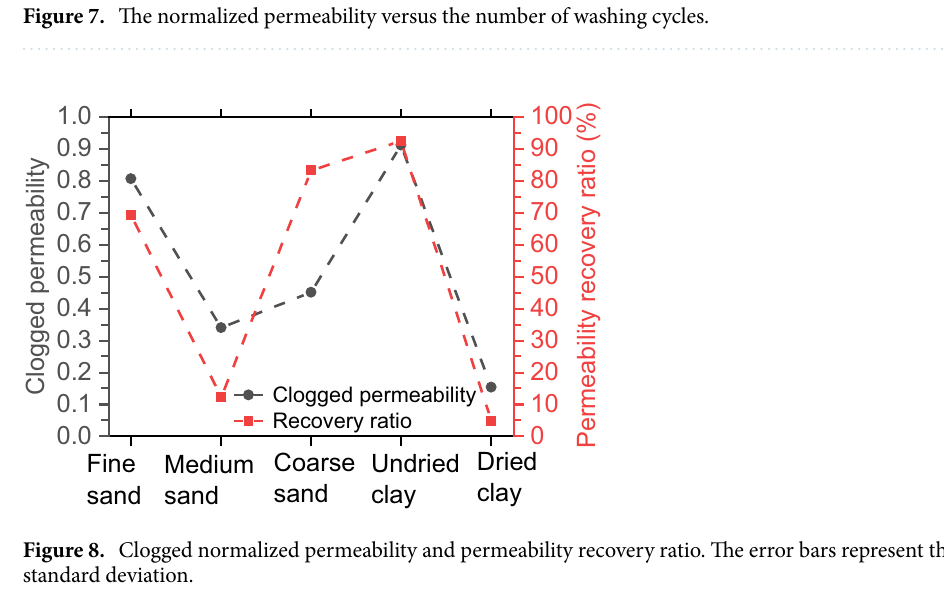
where k c denotes the clogged permeability and k f denotes the final permeability after completing all washing cycles. Figure 8 shows RA and the clogged normalized permeability, which are strongly related to particle size for sand clogging and drying degree for clay clogging (subsequent sections provide the details). Vertical sediment distribution. Figure 9 shows the vertical distributions of sediment in the medium sand-clogged samples before any washing and after 30 washing cycles. In the slice images at the 16 vertical depths, the area of sand washed away is calculated by subtracting the final retained sand area (after 30 washing cycles) from initially retained sand area (before any washing). By dividing washed sand area by initially retained sand area, the ratio of sand washed away is determined. This ratio is referred to as the wash ratio of sand. The definition of the wash ratio of clay is similar. Figure 9 also shows the vertical distribution of the wash ratio of sand. In contrast, Fig. 10 shows the sediment distributions in dried clay-clogged samples before any washing and after 30 washing cycles and the distribution of the wash ratio of clay. By comparing Figs. 9 and 10, it is found that the retained clay mostly occurs within the upper region, while the sand particles are trapped throughout the entire sample before any washing. Clay particles have soil cohesion and easily adhere to the pore wall within the upper region. In contrast, sand particles do not have soil cohesion and can easily enter the lower region. “Sand-clogging and clay-clogging mechanisms” provides the detailed differences between sand-clogging and clay-clogging mechanisms. Sand clogging. For fine sand-clogged samples, the clogged normalized permeability is as high as 0.807, meaning that the clogged permeability is 80.7% of the unclogged permeability. Moreover, only three washing cycles almost recover the permeability to the initial value, with a post-washing normalized permeability of 0.927,